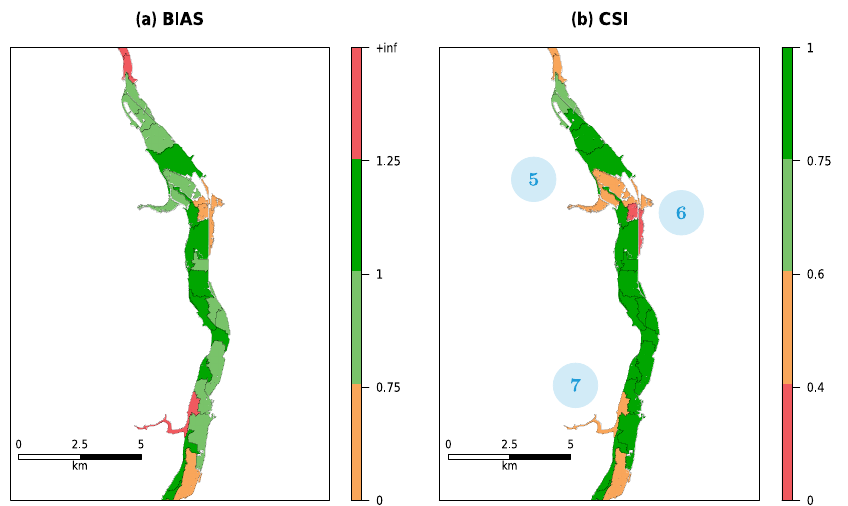
Figure 13. Reach-scale performance of (a) BIAS and (b) CSI for the physical combination of parameters, K ch = 10 and K fp = 5m 1 / 3 s − 1 , for the centre part of the catchment. Criteria values have been categorised as follows: excellent (dark green), good (green), average (orange) and poor (red). The black lines delineate the reaches. Locations 5 to 7 correspond to areas where the model struggles to reproduce the observation (orange and/or red